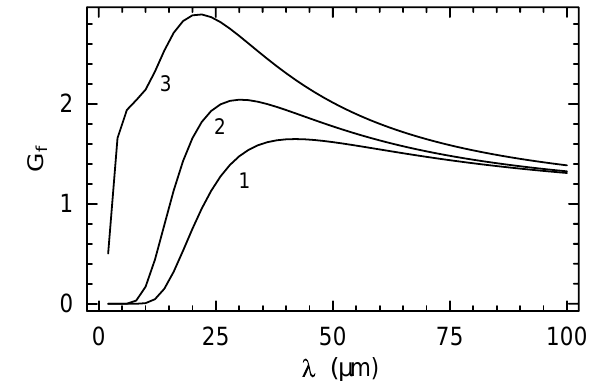
FIG. 5. Amplification factor G (cid:2) s (cid:3) for e (cid:1) 1 m m, s p (cid:1) 3.0 3 10 2 5 for three values of l : ( 1 ) l (cid:1) 50 m m, ( 2 ) l (cid:1) 20 m m, and ( 3 ) l (cid:1) 5 m m.